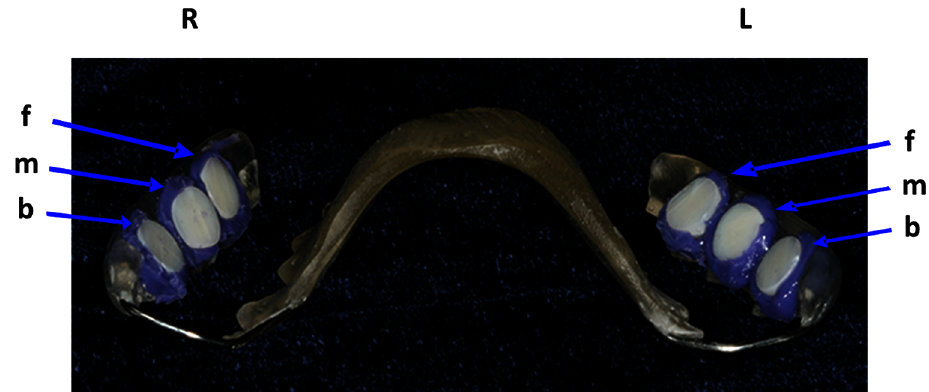
Fig 1. Individual upper jaw acrylic splint with six bovine enamel slabs (BES) embedded in silicon at different sites. The BES were fixed at the front (f), in the middle (m) and at the back (b), for both the right (R) and left (L) sides of the splint. Silicon covered the downward-facing surfaces and the margins of the BES and left only their upward-facing surfaces exposed.